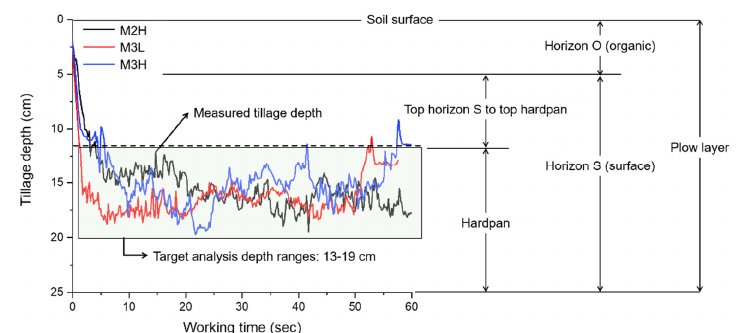
Figure 6. Results analysis of the measured tillage depth in each gear.